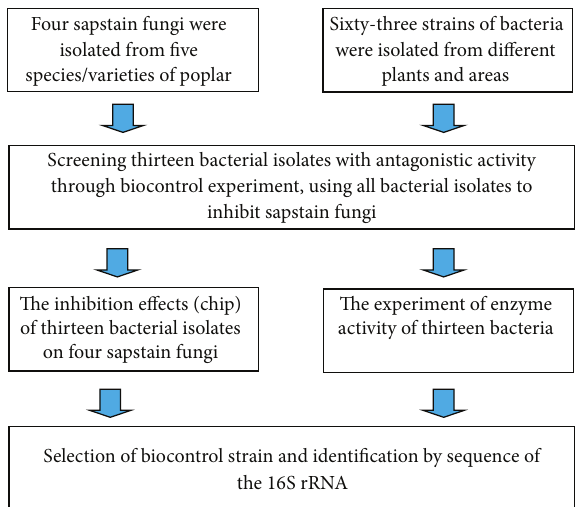
Figure 1: Selection method of biocontrol bacteria for poplar